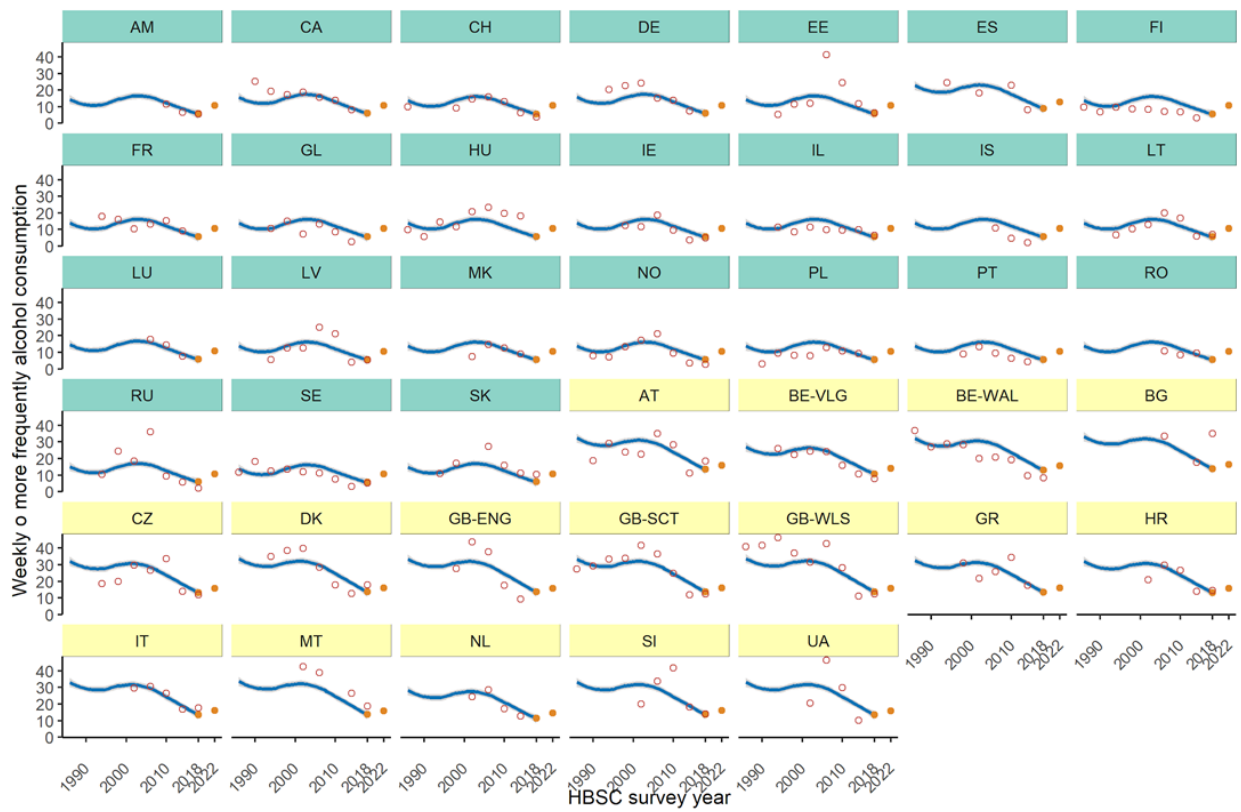
Figure 1. Trends (empty circles) and estimated (full circles for 2017/18 and 2021/22 waves) preva- lence, (%) by country. Countries are grouped according to clusterization (different colours). Boys.